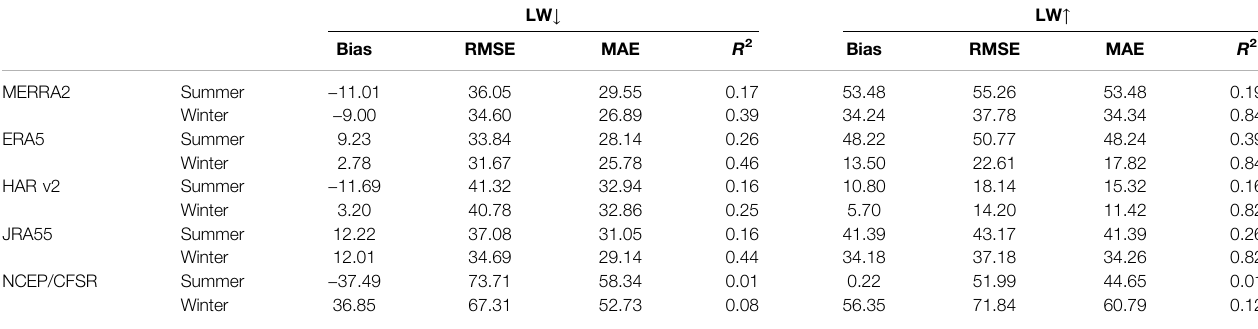
TABLE 8 | Results of the fi ve sets of reanalysis datasets for longwave radiation evaluated in summer and winter. LW ↓ LW ↑ Bias RMSE MAE R 2 Bias RMSE MAE R 2